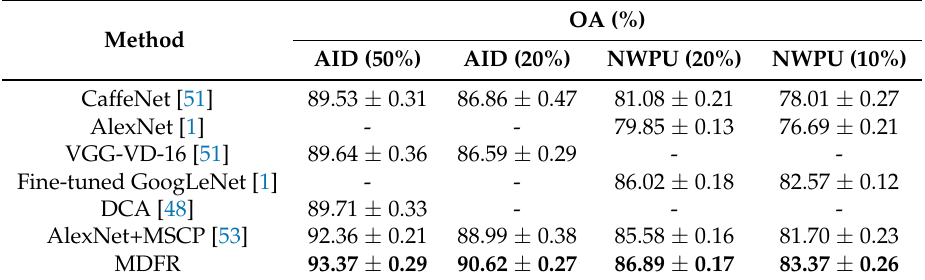
Table 6. Comparison of classification accuracy with other methods. The best results are in